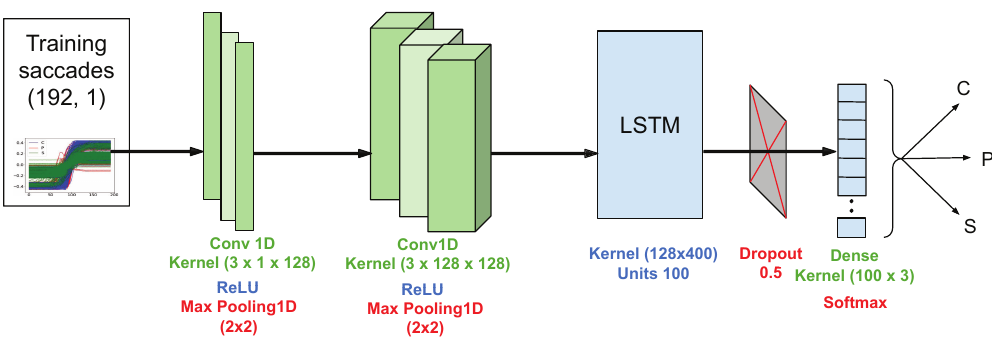
Figure 4. Proposed CNN-LSTM architecture. MCD intervenes in the final dropout layer, with a different mask for every forward pass.